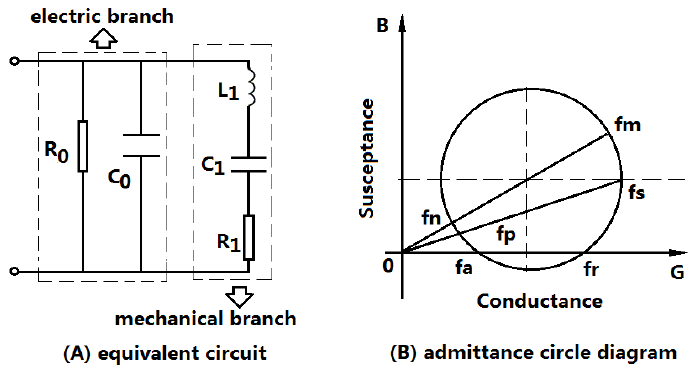
Figure 1. A lumped electromechanical equivalent circuit and admittance circle diagram of a piezoelectric transducer at resonance.